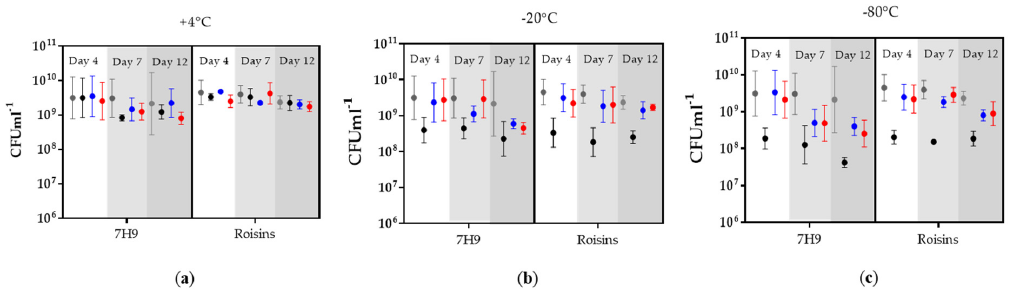
Figure 3. The total viable counts of M. bovis BCG cultured in Middlebrook or Roisin’s; pre-storage ( • ) and after 24h of storage at ( a ) +4 °C, ( b ) − 20 °C, & ( c ) − 80 °C in three di ff erent cryoprotectant solutions: